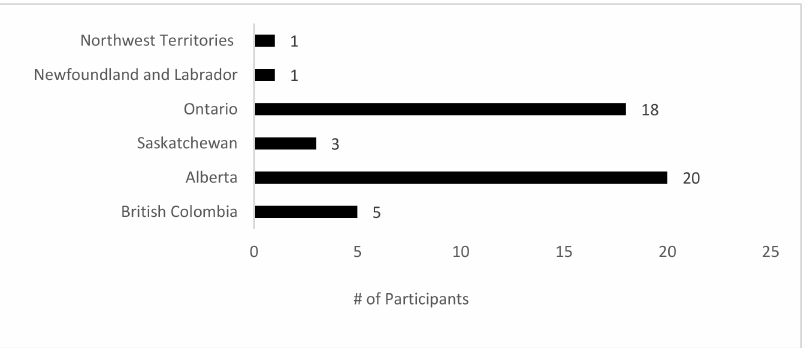
Figure 1. Number and location of those participating in this